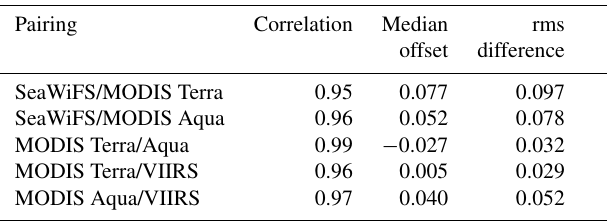
Table 5. Comparative statistics for monthly mean AAC 550nm AOD between the four AAC data sets generated in this work. Off- sets are defined subtracting the second indicated sensor from the first. Pairing Correlation SeaWiFS/MODIS